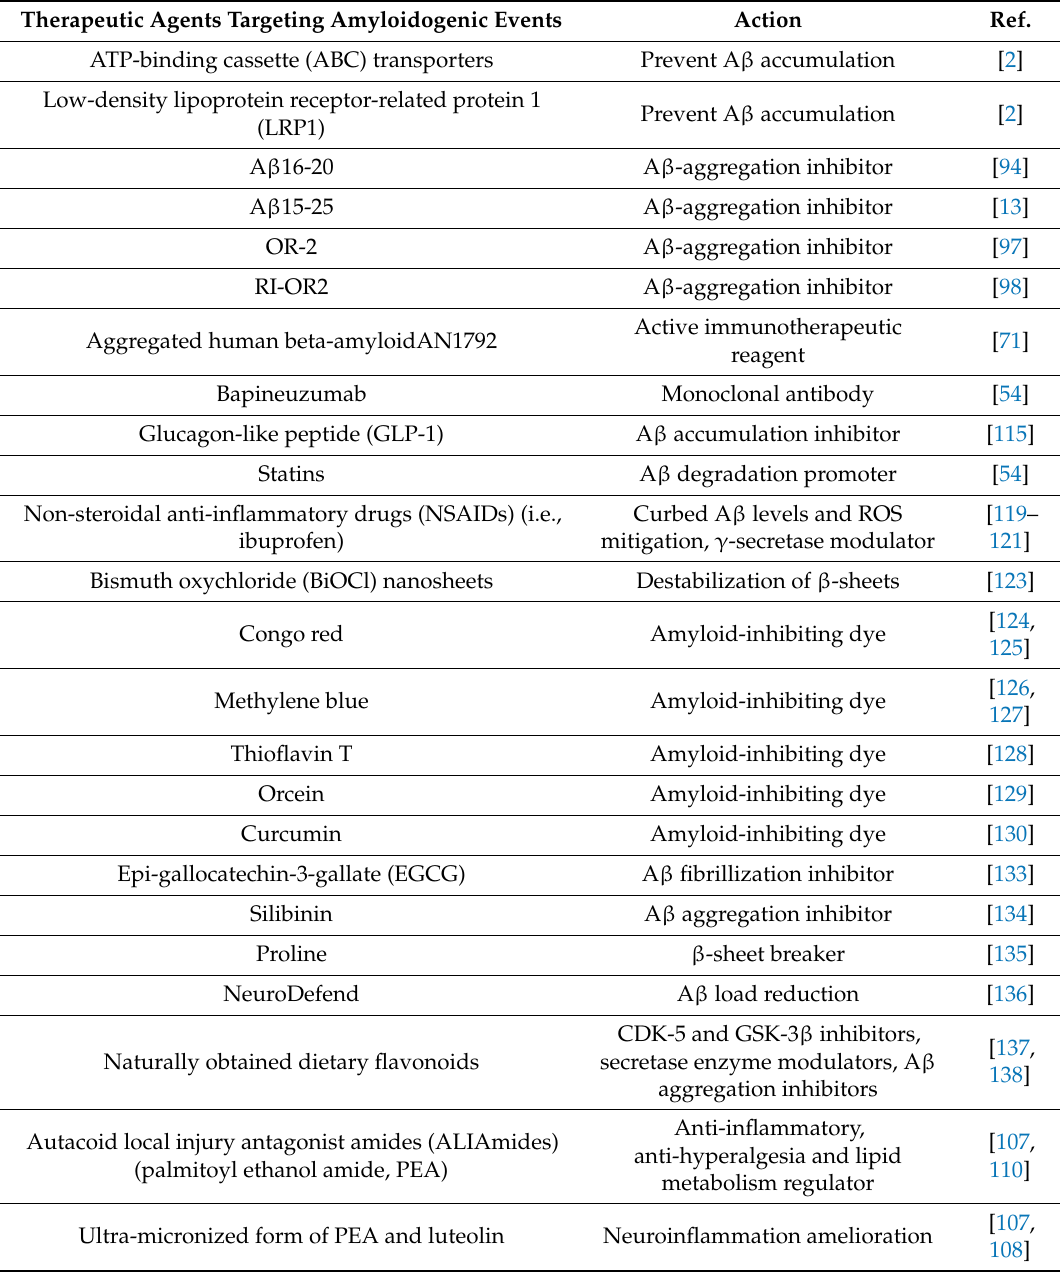
Table 1. Therapeutic agents targeting A β peptides in Alzheimer’s disease